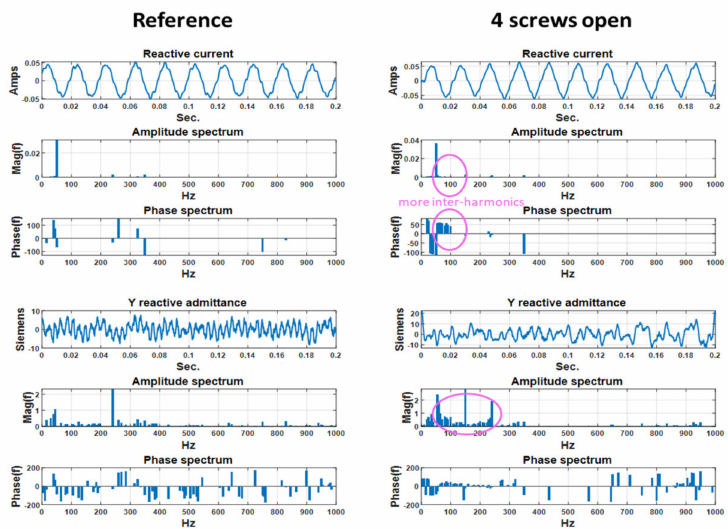
Figure 17. Loaded AC motor: reactive current and admittance in nonvibrating and vibrating cases. Reactive admittance significantly enhances